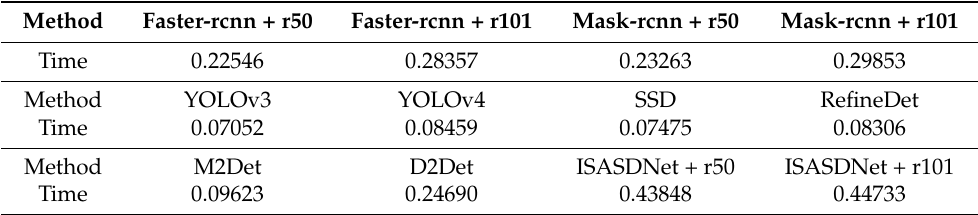
Table 7. Inference time